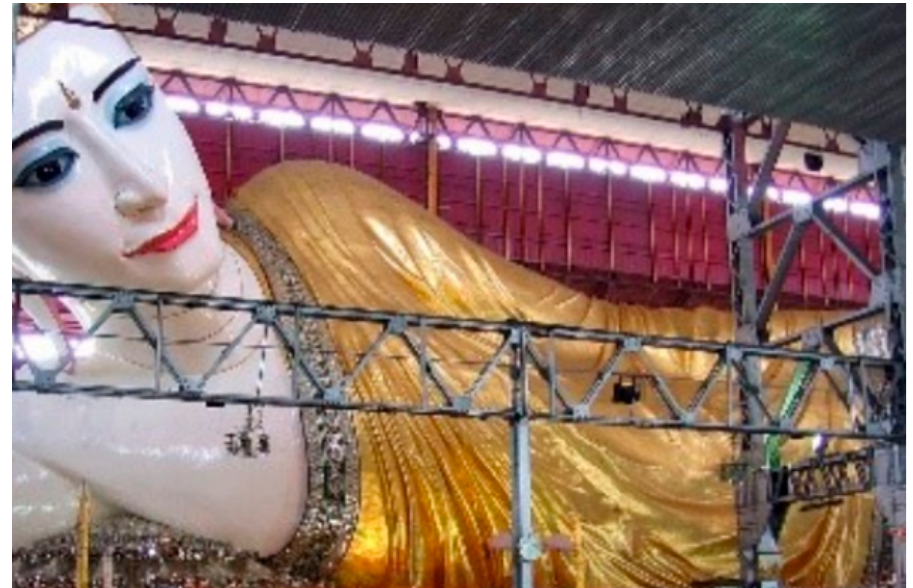
Figure 13. The reclining Buddha, just dying, in Myanmar. A